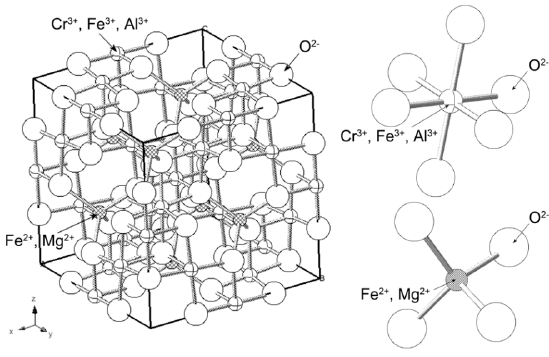
Figure 1. Crystalline structure of chromite spinel [45].